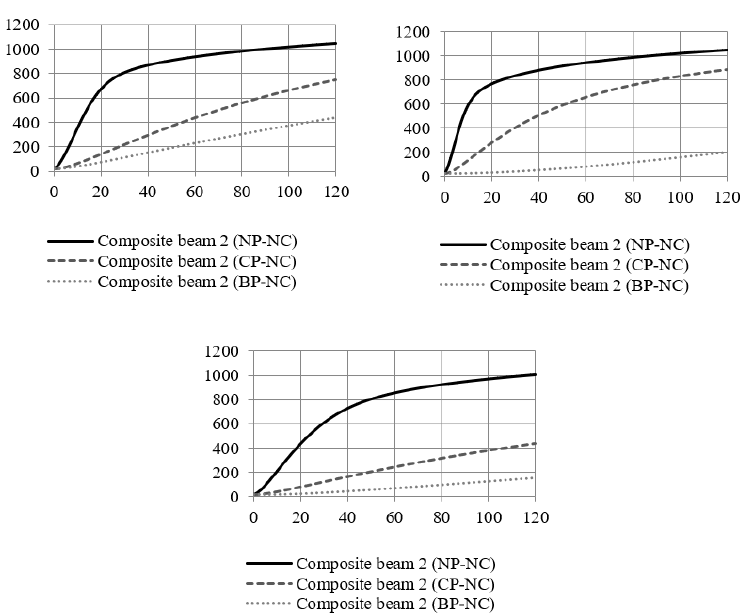
Figure 14. Temperature development in composite beam 2 with and without fire protection coating during the time of exposure to